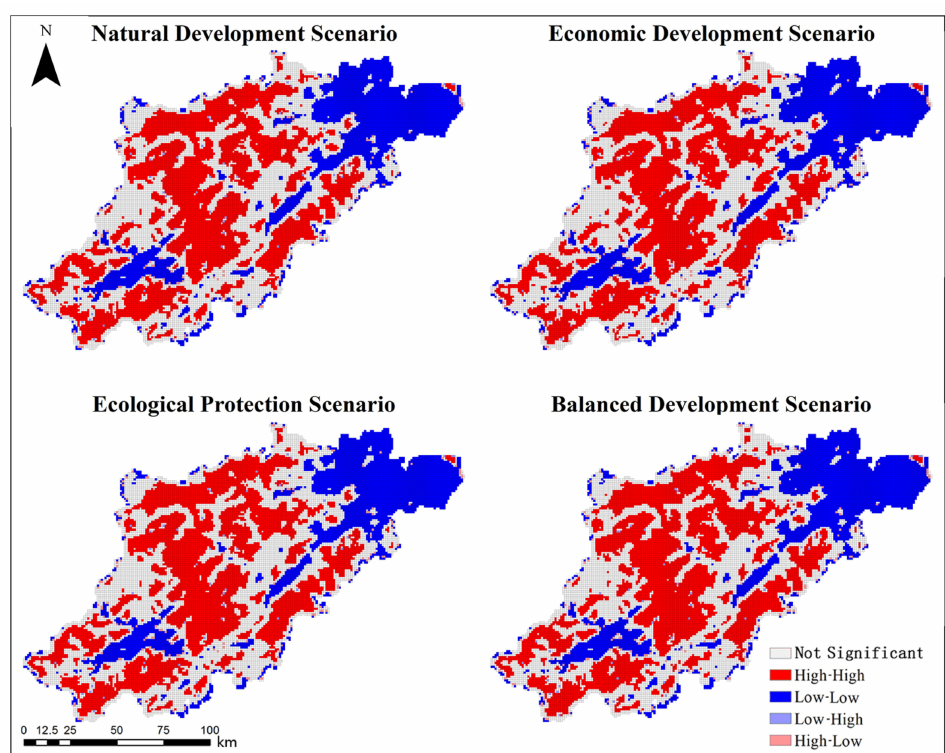
Figure 10. LISA agglomeration diagrams of the carbon storage in Hangzhou under the four scenarios in